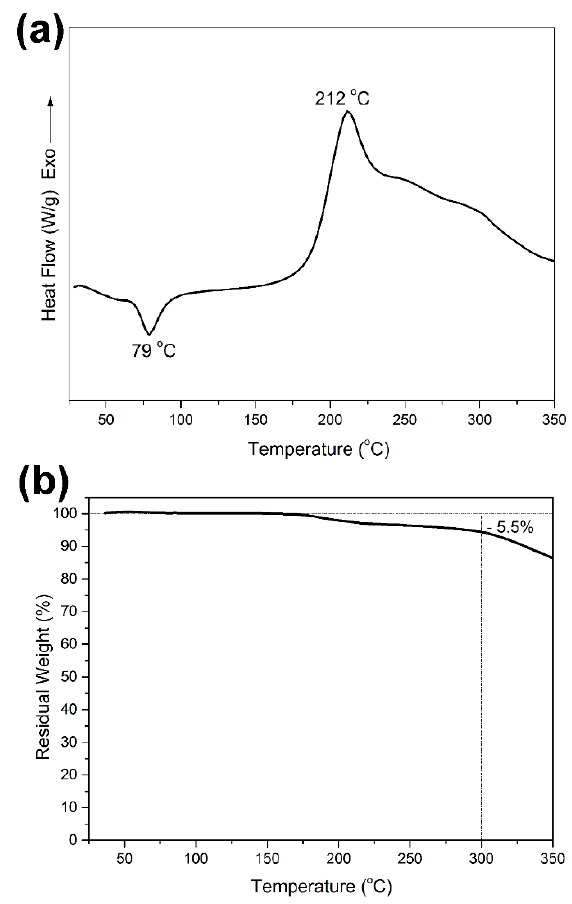
Figure 4. Differential scanning calorimeter DSC ( a ) and TGA ( b ) thermograms of RES-al. Figure 4. Di ff erential scanning calorimeter DSC ( a ) and TGA ( b ) thermograms of